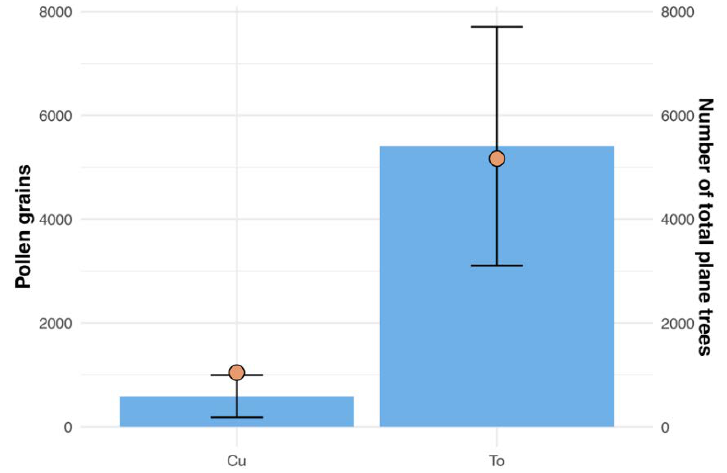
Figure 5. Annual total pollen (bars) and number of total plane trees (points) in the cities of Cuenca (Cu) and Toledo (To). Whiskers are standard deviation of mean annual pollen integral.